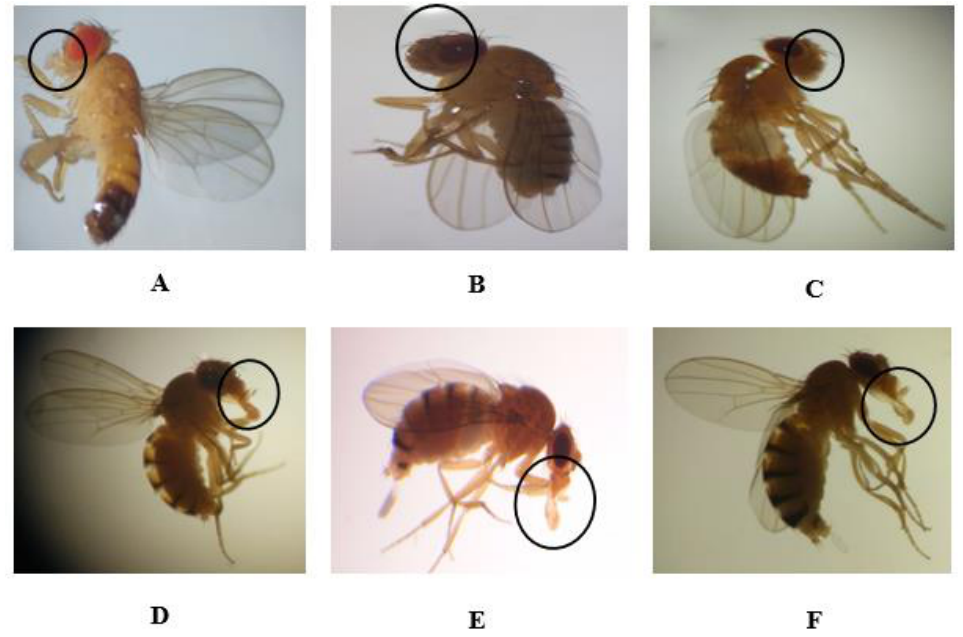
Figure 3. Normal ( A ) and abnormal mouth phenotypes ( B – F ) in the F0, F1, F2, and F3 generations obtained after treatment with permethrin (0.1 mM), permethrin nanopesticides (2.5 mM), acephate and acephate nanopesticides (5 mM), and validamycin and validamycin nanopesticides (2.5 mM) for Drosophila larvae. Black circles indicate the defective area in the image.